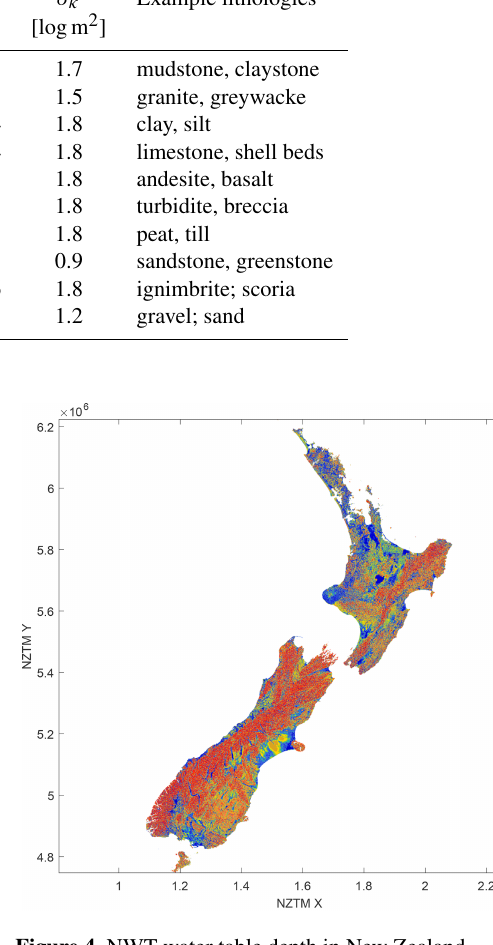
Figure 4. NWT water table depth in New